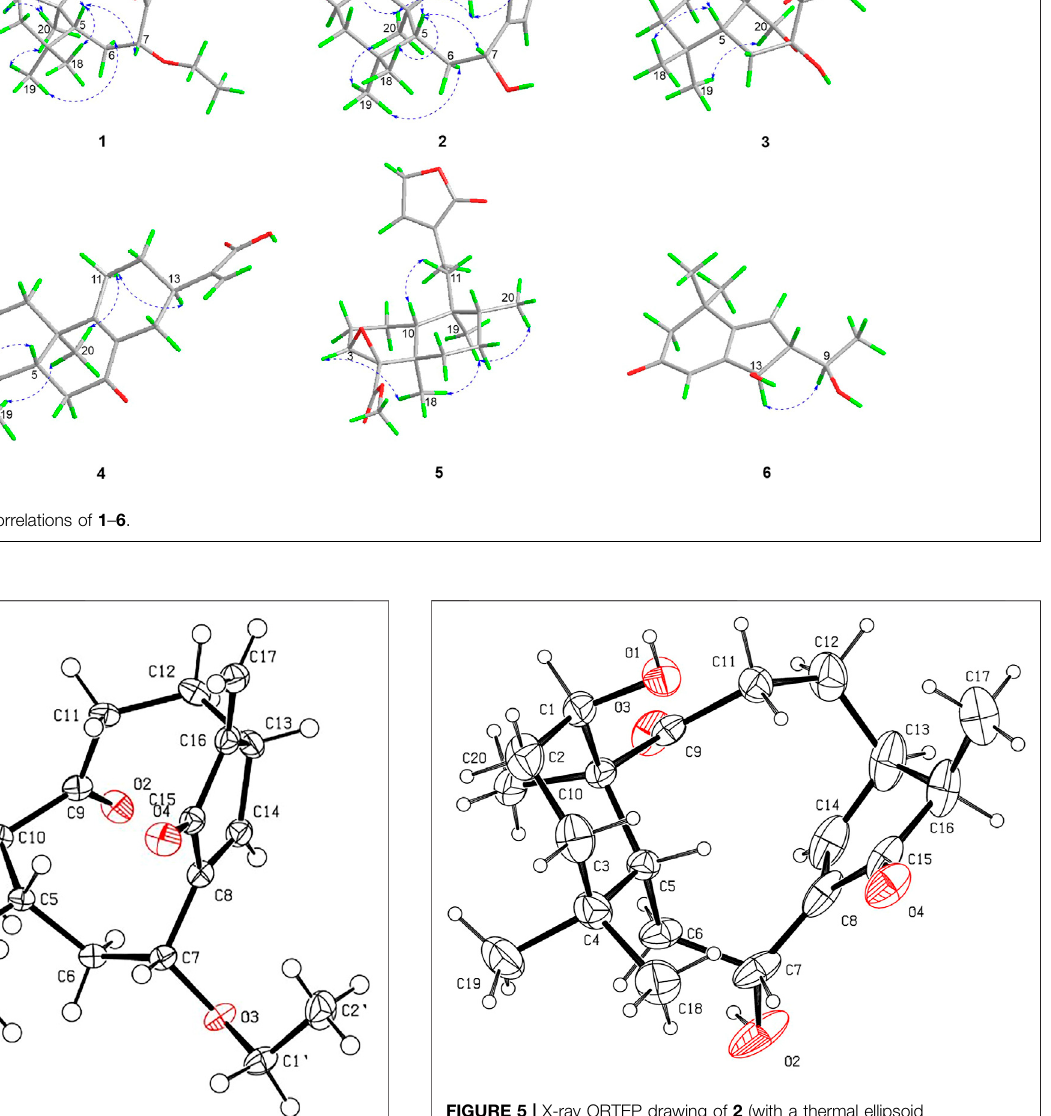
FIGURE 5 | X-ray ORTEP drawing of 2 (with a thermal ellipsoid probability of